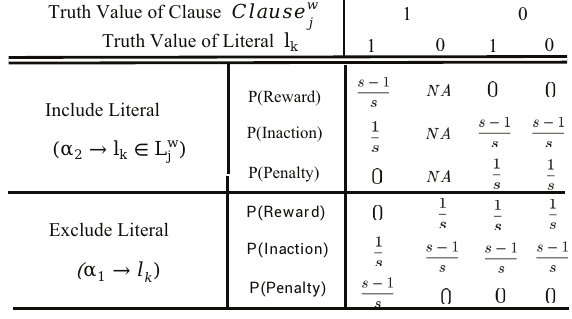
Figure 4. Type I Feedback.